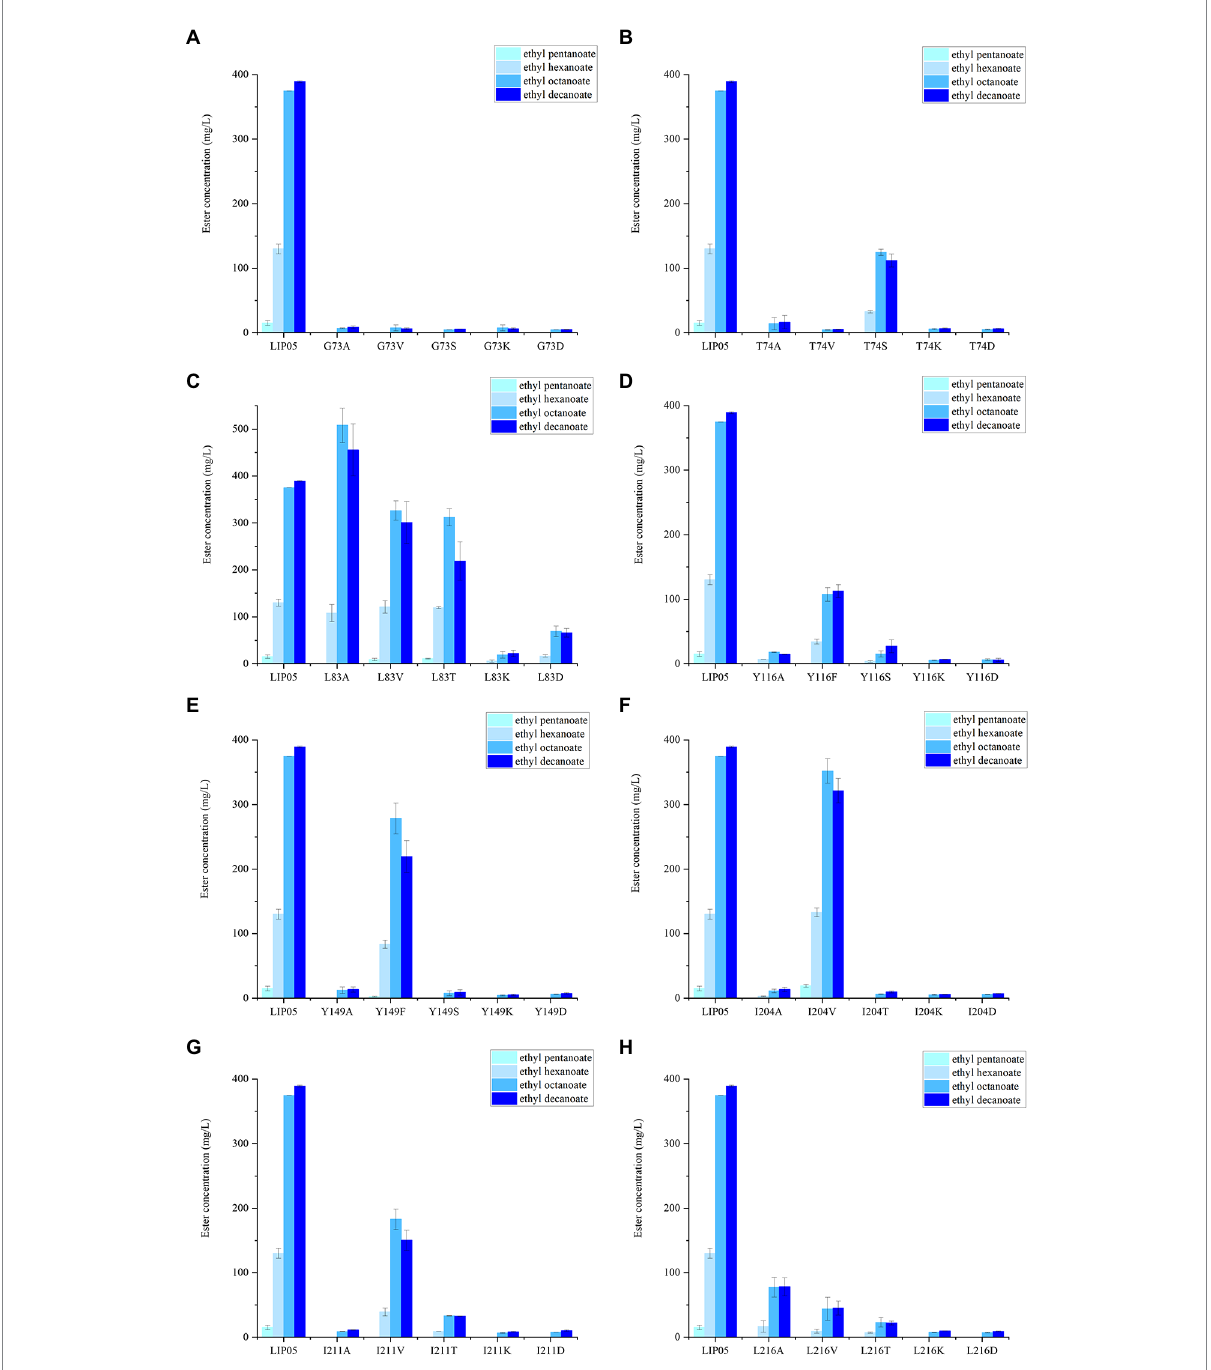
FIGURE 5 The ester synthesis ability of the mutants at (A) Gly73, (B) Thr74, (C) Leu83, (D) Tyr116, (E) Tyr149, (F) Ile204, (G) Ile211, (H)